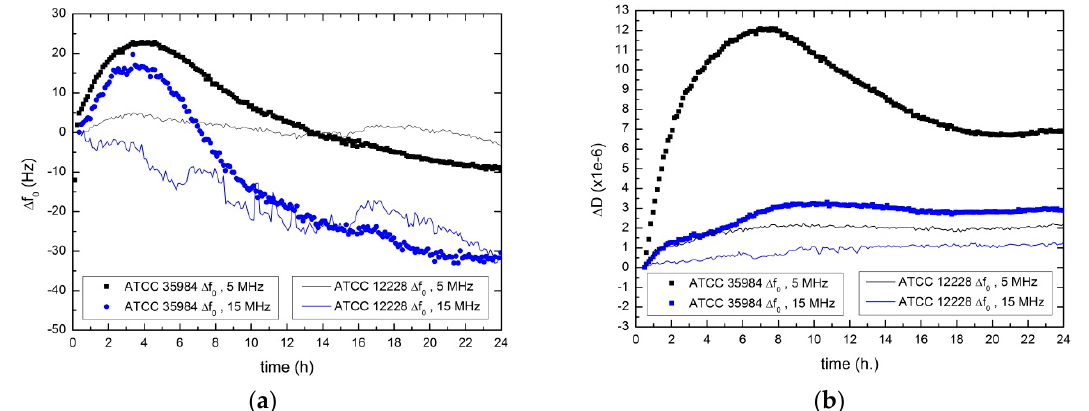
Figure 5. Evolution of Δ ƒ 0 ( a ) and ∆ D parameter ( b ) for the two frequencies analyzed (5 MHz –black- and 15 MHz –blue-). The biofilm-producing ( ATCC 35984) and non-producing ( ATCC 12228) strain tests are plotted with symbols and continuous lines, respectively.